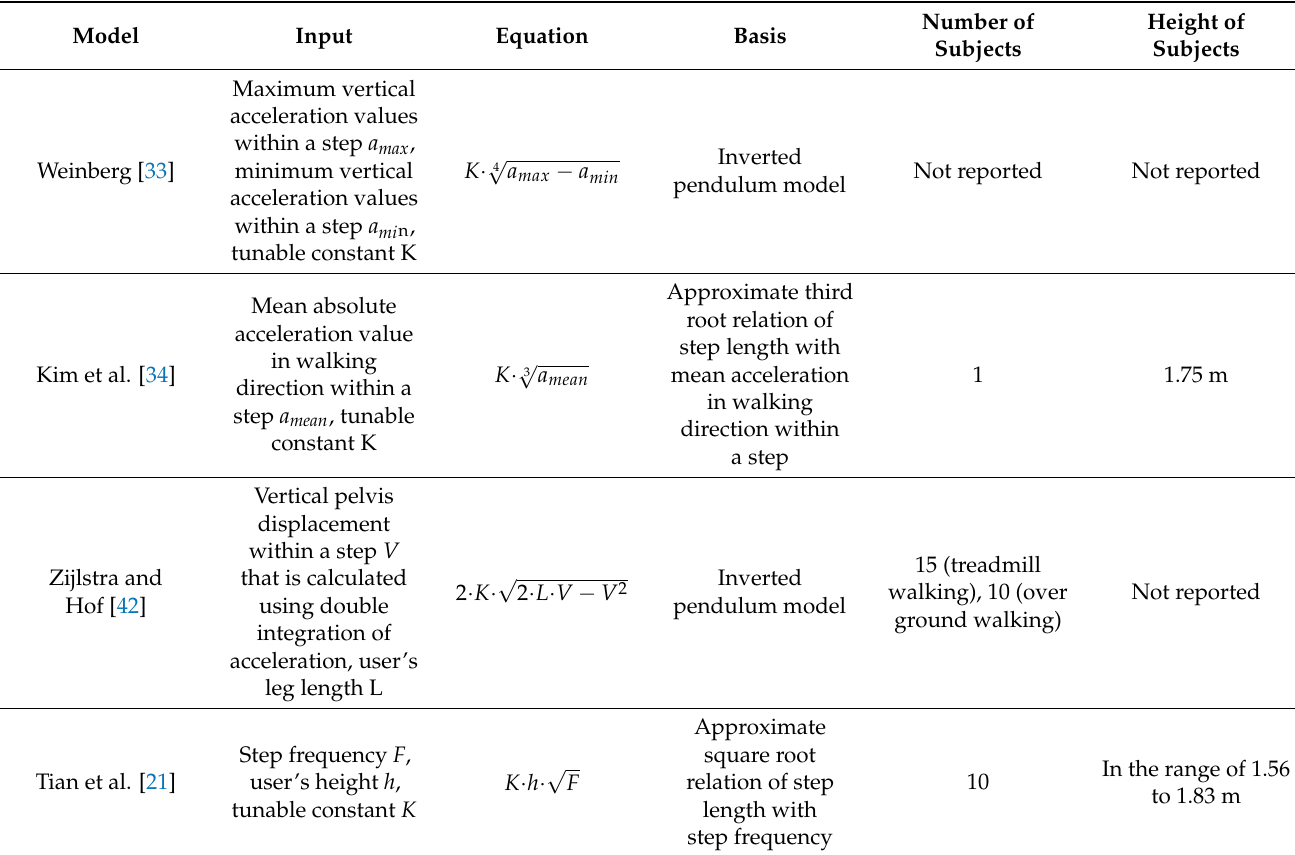
Table 1. Step length estimation models selected for the comparison, their properties, and information about the participants.